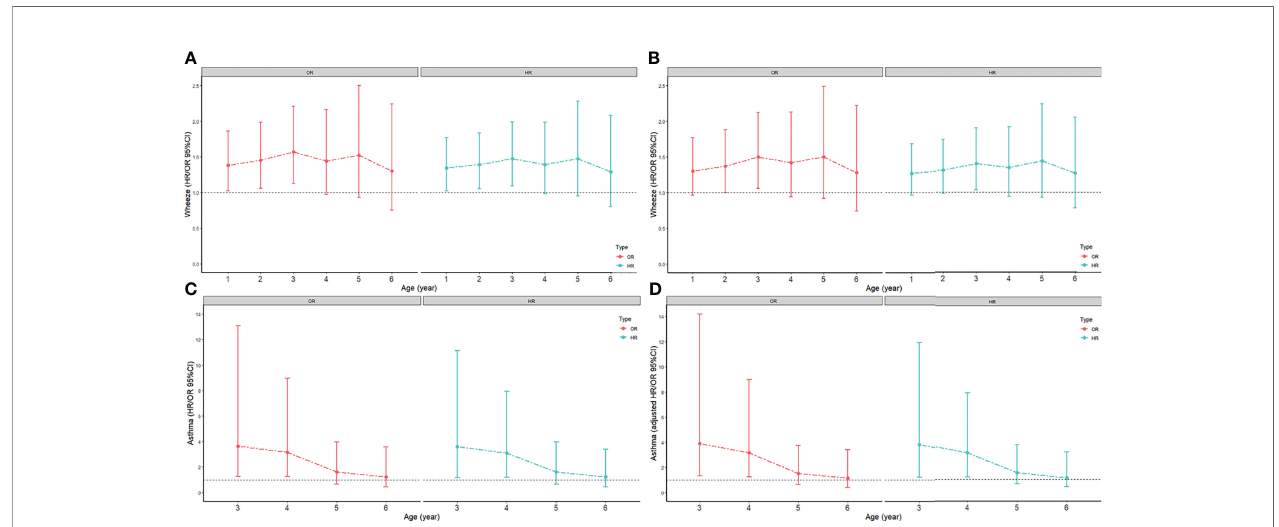
FIGURE 1 | The odds ratio (ORs) and 95% con fi dence intervals (CIs) for the association between CD and FEW or asthma. Models were adjusted for premature or full-term delivery, breastfeeding status. The age-dependent association between CD and FEW or asthma was assessed by hazard ratios (HRs), with time of development of FEW and asthma as the underlying time metric. (A) the crude ORs and HRs for FEW; (B) the adjusted ORs and adjusted HRs for FEW; (C) the crude ORs and HRs for asthma; (D) the adjusted ORs and adjusted HRs for